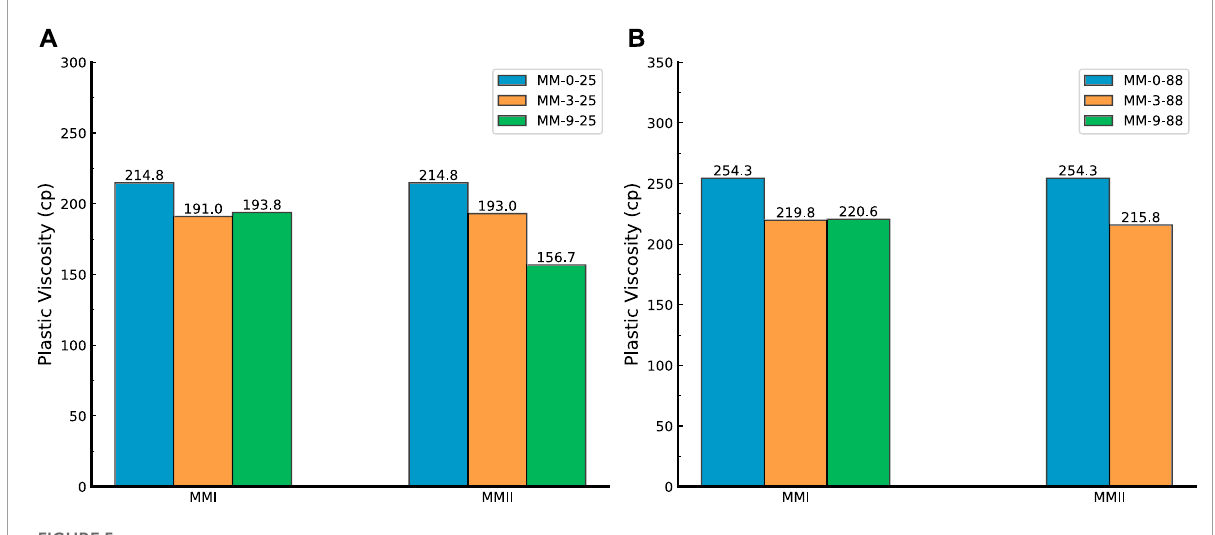
FIGURE 5 Plastic viscosity of slurry samples. (A) Slurry samples (mixed with MMII and MMI, respectively) tested under 25 ° C; (B) slurry samples (mixed with MMII and MMI, respectively) tested under 88 ° C; MMI refers to type I micro-sized magnesium oxide; MMII refers to type II micro-sized magnesium oxide; MM refers to micro-sized magnesium oxide.